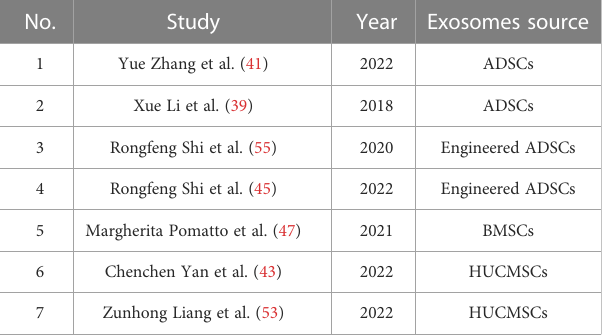
TABLE 2 MSCs-exo in promoting